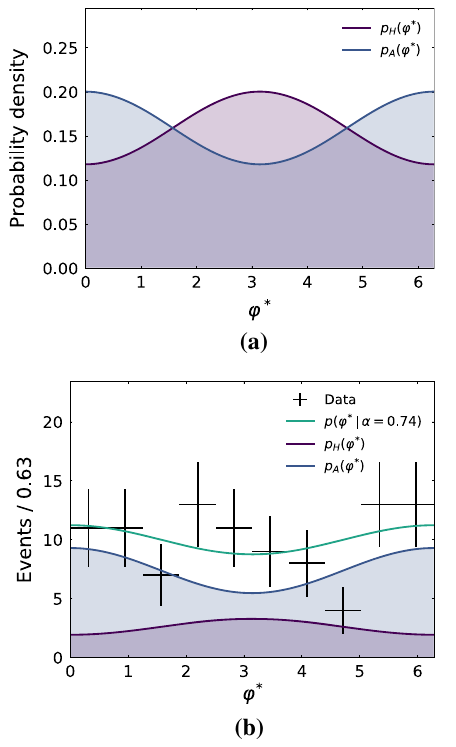
Fig. 2 a The probability density for ϕ ∗ in H events ( p H (ϕ ∗ ) ) and A events ( p A (ϕ ∗ ) ). b A fit of the mixture model p (ϕ ∗ | α) = α p A (ϕ ∗ ) + ( 1 − α) p (ϕ ∗ ) to a test dataset. Data points are shown in black, while H the fitted model (normalized to 100 events) is shown in green. For this dataset the best-fit α value is ˆ α = 0 .